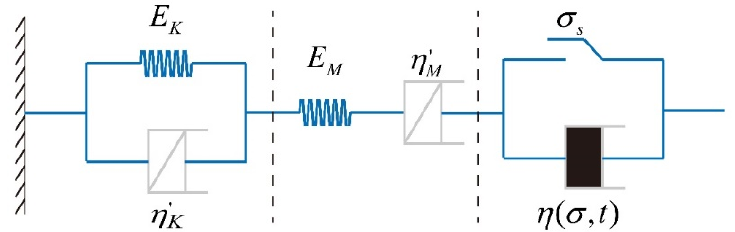
Figure 9. A new fractional nonlinear viscoelastic-plastic model.